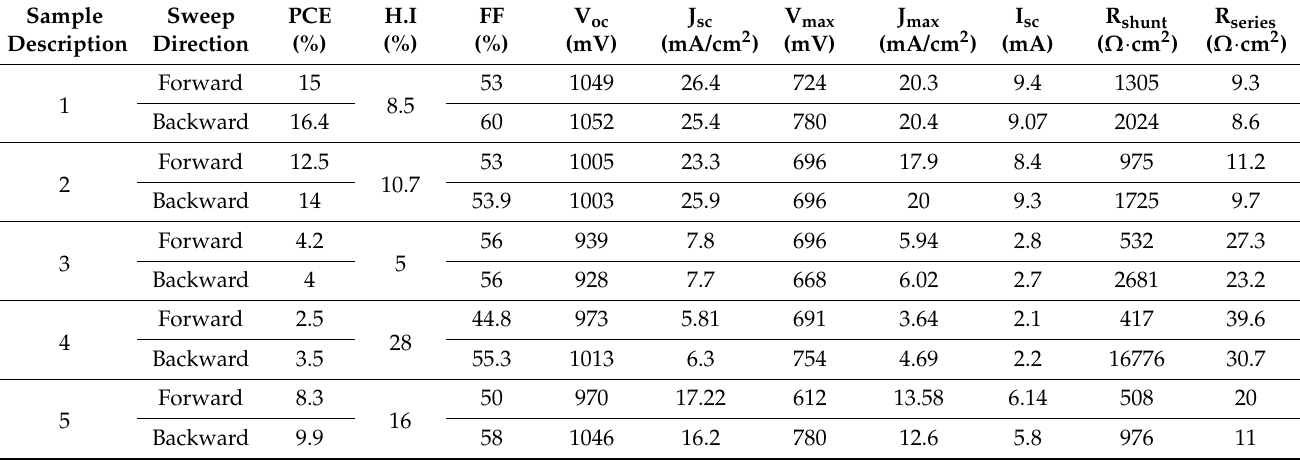
Table 3. Perovskite solar cell key parameters measured for different compositions of the perovskite active layer.